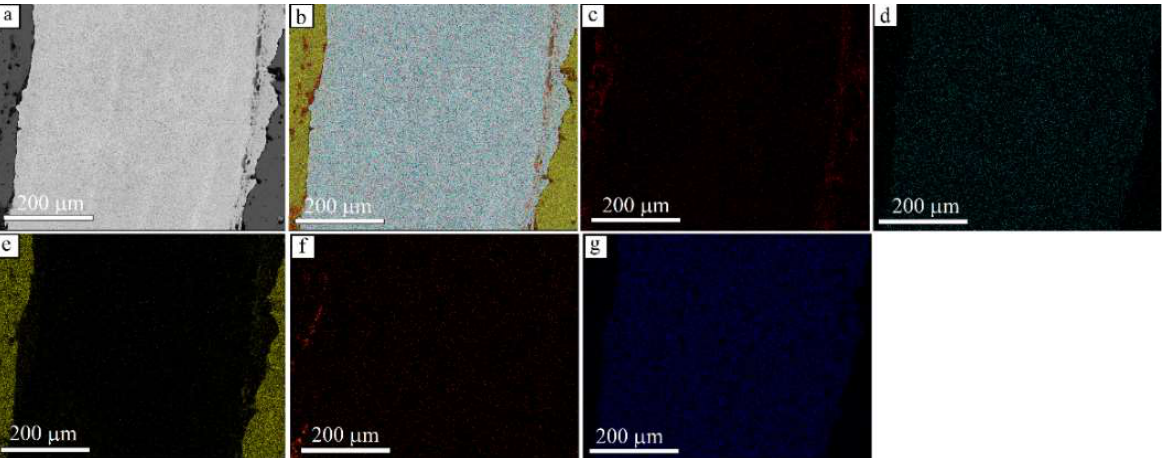
Figure 12. SEM image ( a ) and EDS element distribution maps for all elements ( b ), O ( c ), W ( d ), Zr ( e ), Fe ( f ) and Co ( g ) obtained from the worn surface of the ZrN coating after sliding at 6N.